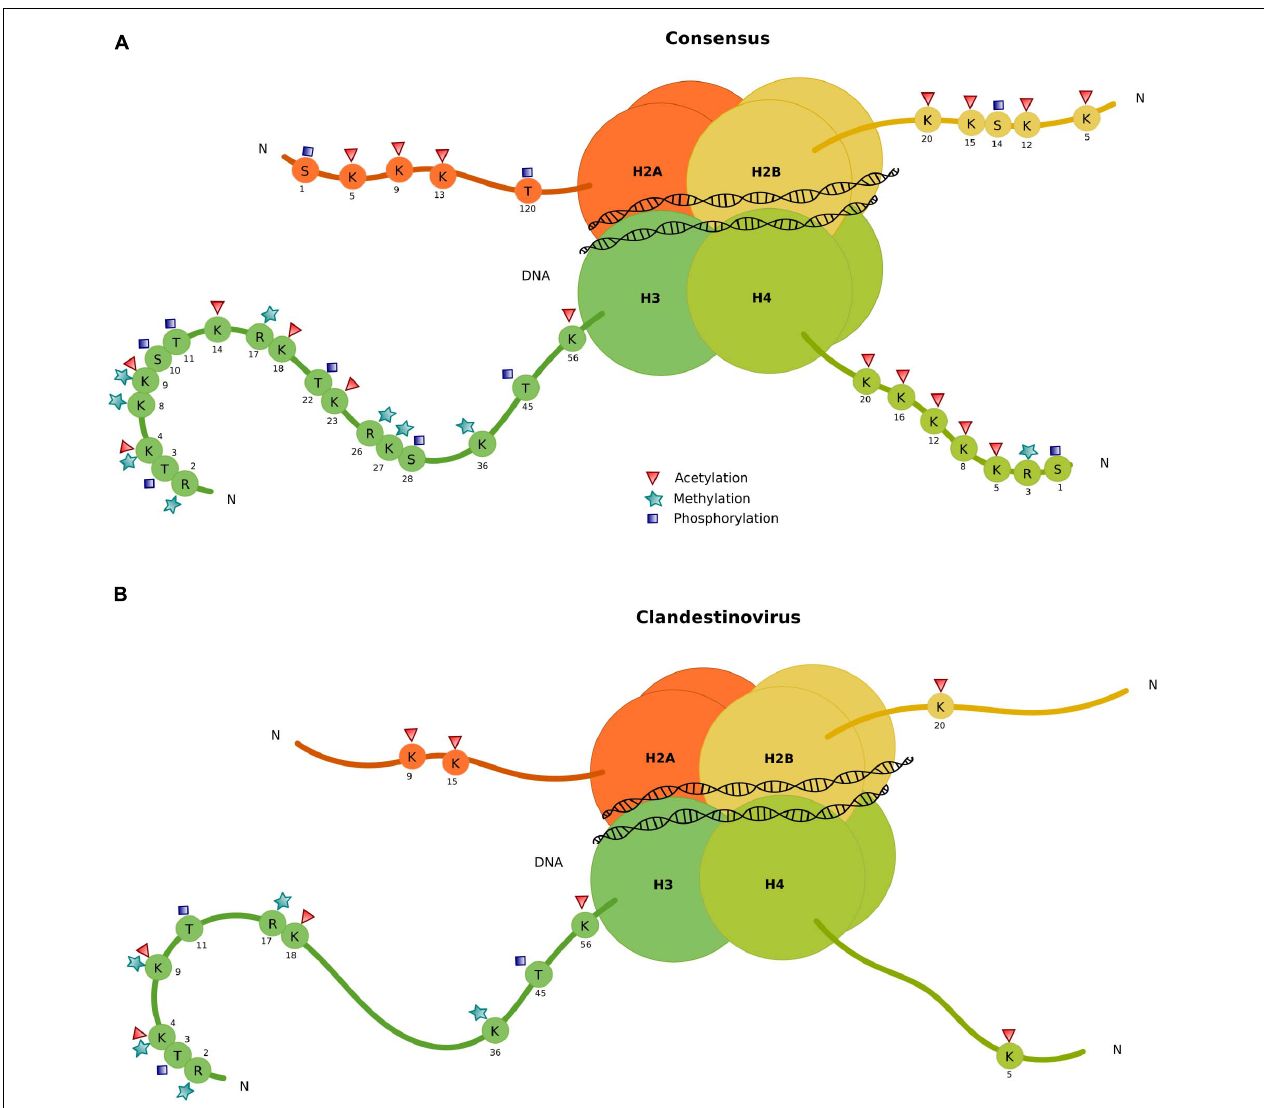
FIGURE 4 | Conservation of specific modification sites in N-terminal tails of clandestinovirus histones. (A) Consensus. (B) Histone conserved modification sites in